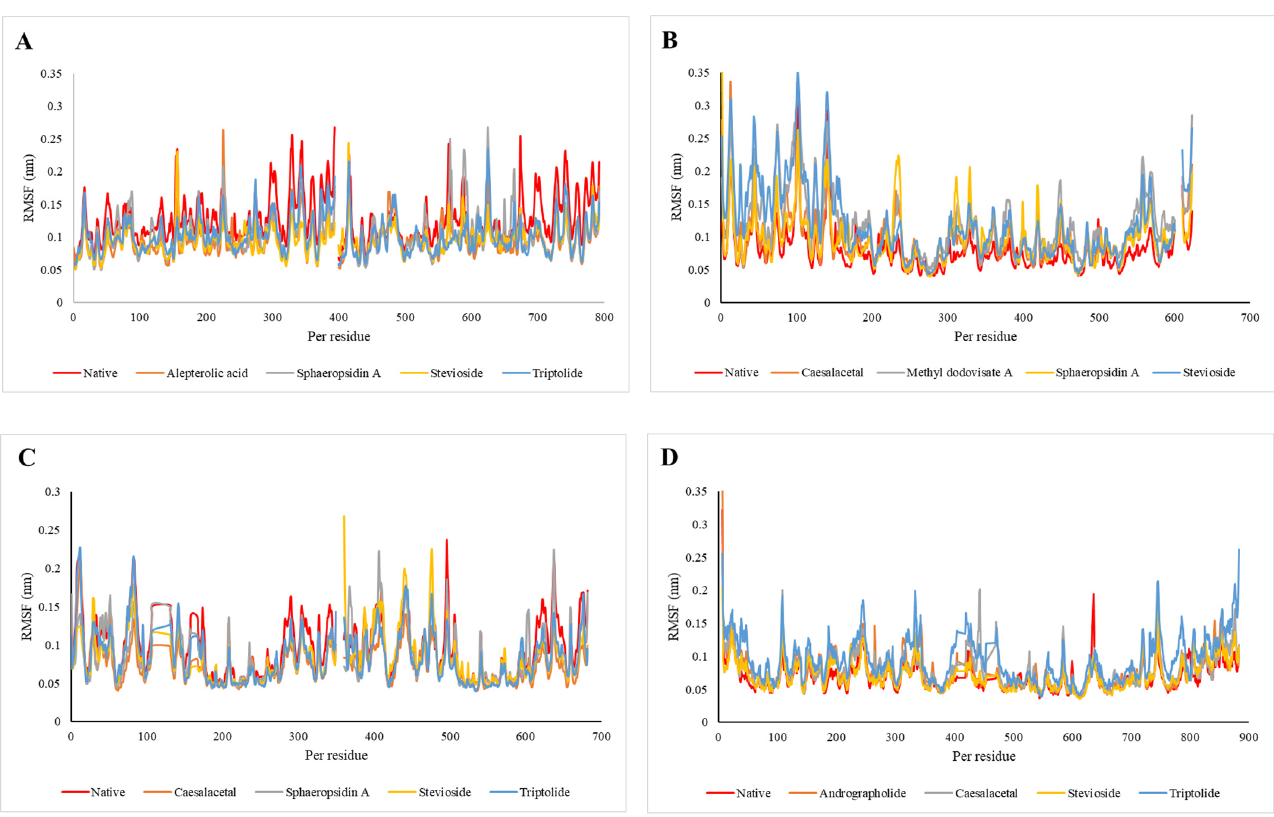
Figure 9. The RMSF plot for the backbone atoms for ( A ) 1OKE, ( B ) 2VBC, ( C ) 4O6 Band ( D ) 4V0Q.